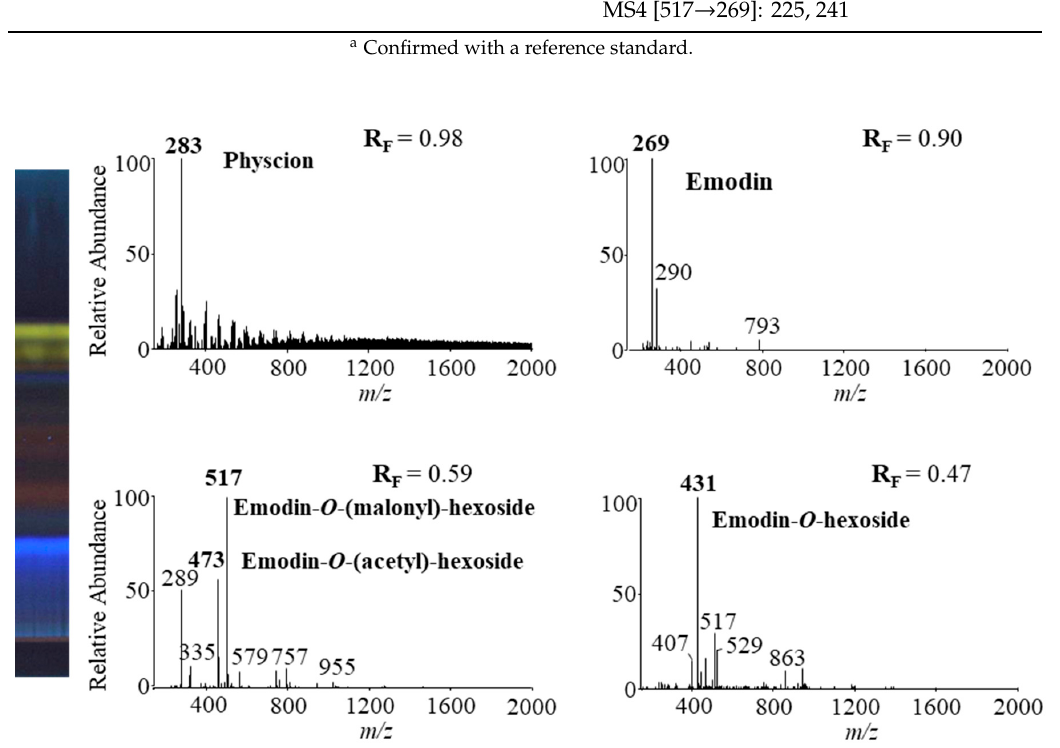
Figure 11. MS spectra of anthraquinones (bold, m / z ) obtained from Japanese knotweed rhizomes STS from a twice predeveloped HPTLC silica gel plate developed up to 7 cm with toluene–acetone–formic acid (6:6:1, v / v ) as the developing solvent and documented at 366 nm.